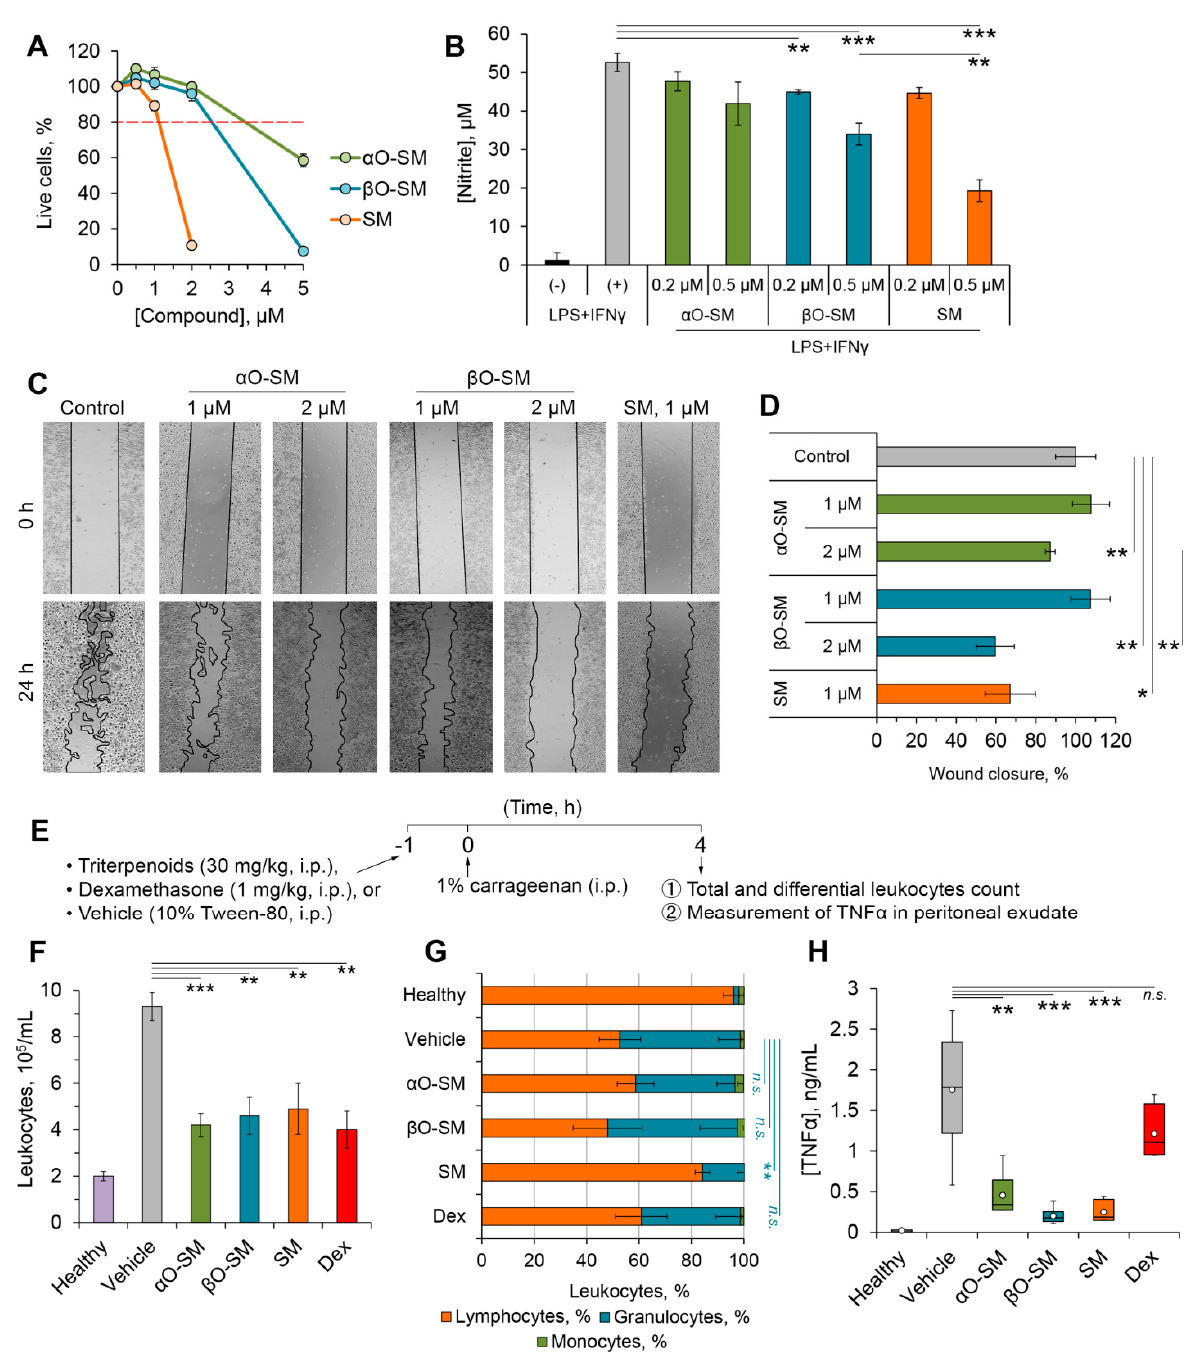
Figure 5. Anti-inflammatory potential of SM epoxides in vitro and in vivo. ( A ) The effect of SM-epoxides on the viability of murine J774 macrophages. ( B ) The effect of SM epoxides on NO production by IFN γ /LPS-stimulated J774 cells. ( C , D ) The effect of SM-epoxides on the motility of J774 cells. Representative images ( C ) and quantitative data ( D ) of scratch assay represented the mean ± SD of three independent experiments. ( E – H ) Effect of SM-epoxides on the development of carrageenan-induced peritonitis in vivo. ( E ) Experimental setup. Balb/C mice were pretreated in- traperitoneally (i.p.) with α O-SM , β O-SM , SM (30 mg/kg in 10% Tween-80) or dexamethasone (1 mg/kg) 1 h prior to peritonitis induction by i.p. injection of 1% carrageenan. Four hours after peri- tonitis induction, mice were sacrificed, and peritoneal exudates were obtained. ( F – H ) Total ( F ) and